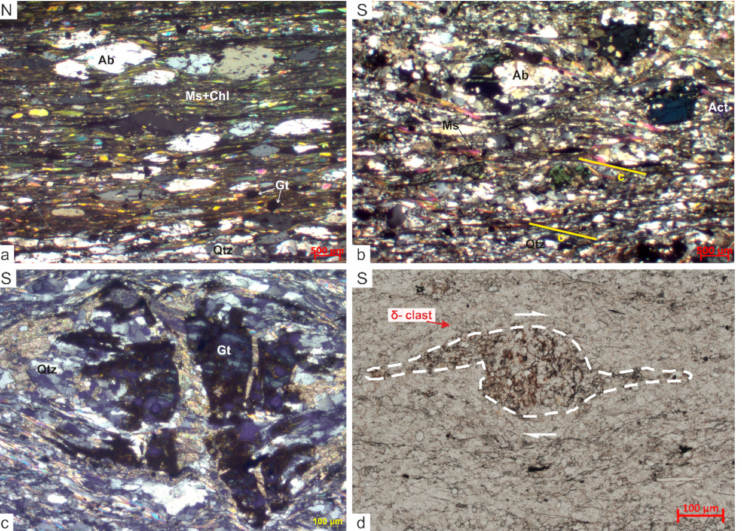
Figure 6. Thin sections (crossed polars) normal to the foliation and parallel to the stretching lineation (L2). ( a ) Upper Schist Fm. from the southwestern Iraklia (IRA_1509) comprising albite, quartz, chlorite, epidote, muscovite and rare post-tectonic garnet. S/C’ shear bands indicate top-to-the- north shearing, ( b ) top-to-the-N S/C’ shear bands in the paragneissic rock of the Lower Schist Fm. (IRA_1507), ( c ) boudinaged and rotated pre-tectonic garnet towards the S, and ( d ) Delta-type calcite+siderite clast indicating top-to-the-N shearing (white